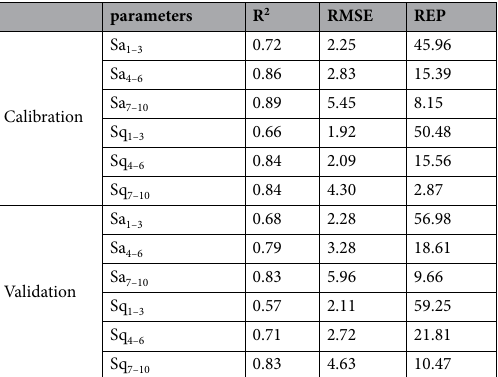
parameters R 2 RMSE REP